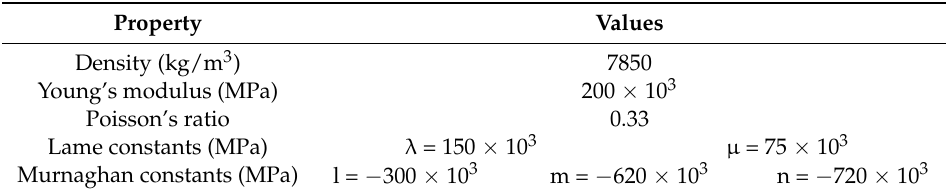
Table 3. The material constants of structural steel [24].